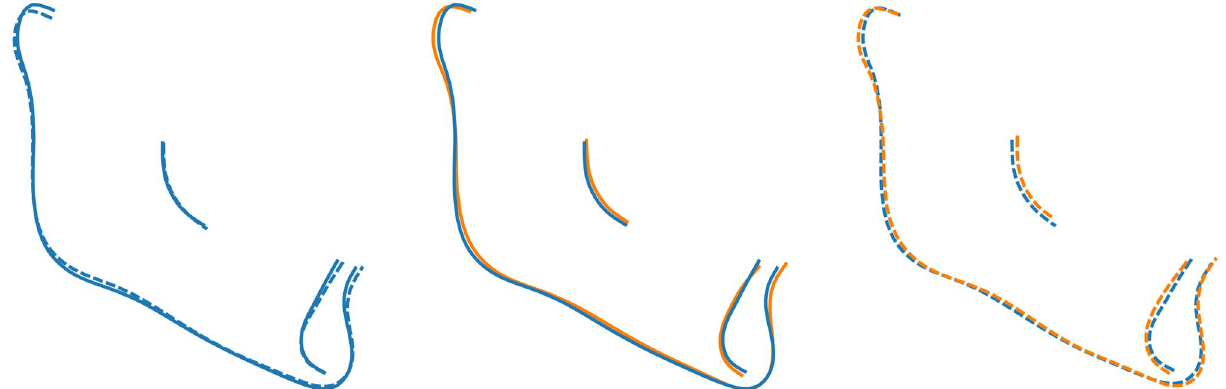
Figure 11. Procrustes superimposition of the average shapes of the mandible. Orange: βTh group, blue: Ctrl group, solid line: males, dotted line: females. Left: control group, centre: males of control and βTh groups, right: females of control and βTh